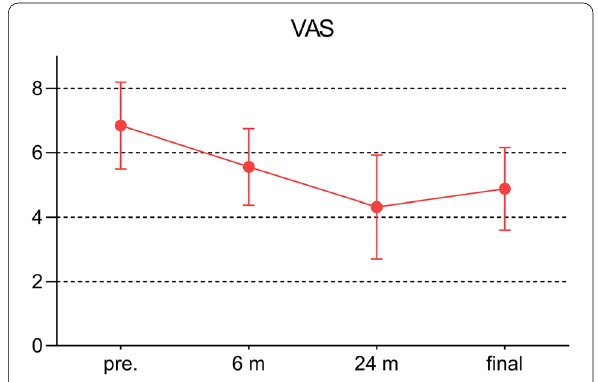
Fig. 4 Trend in the VAS score, with the results obtained preoperatively, at 6 and 24 months postoperatively, and at the final follow-up shown. VAS visual analogue scale, Pre . preoperative